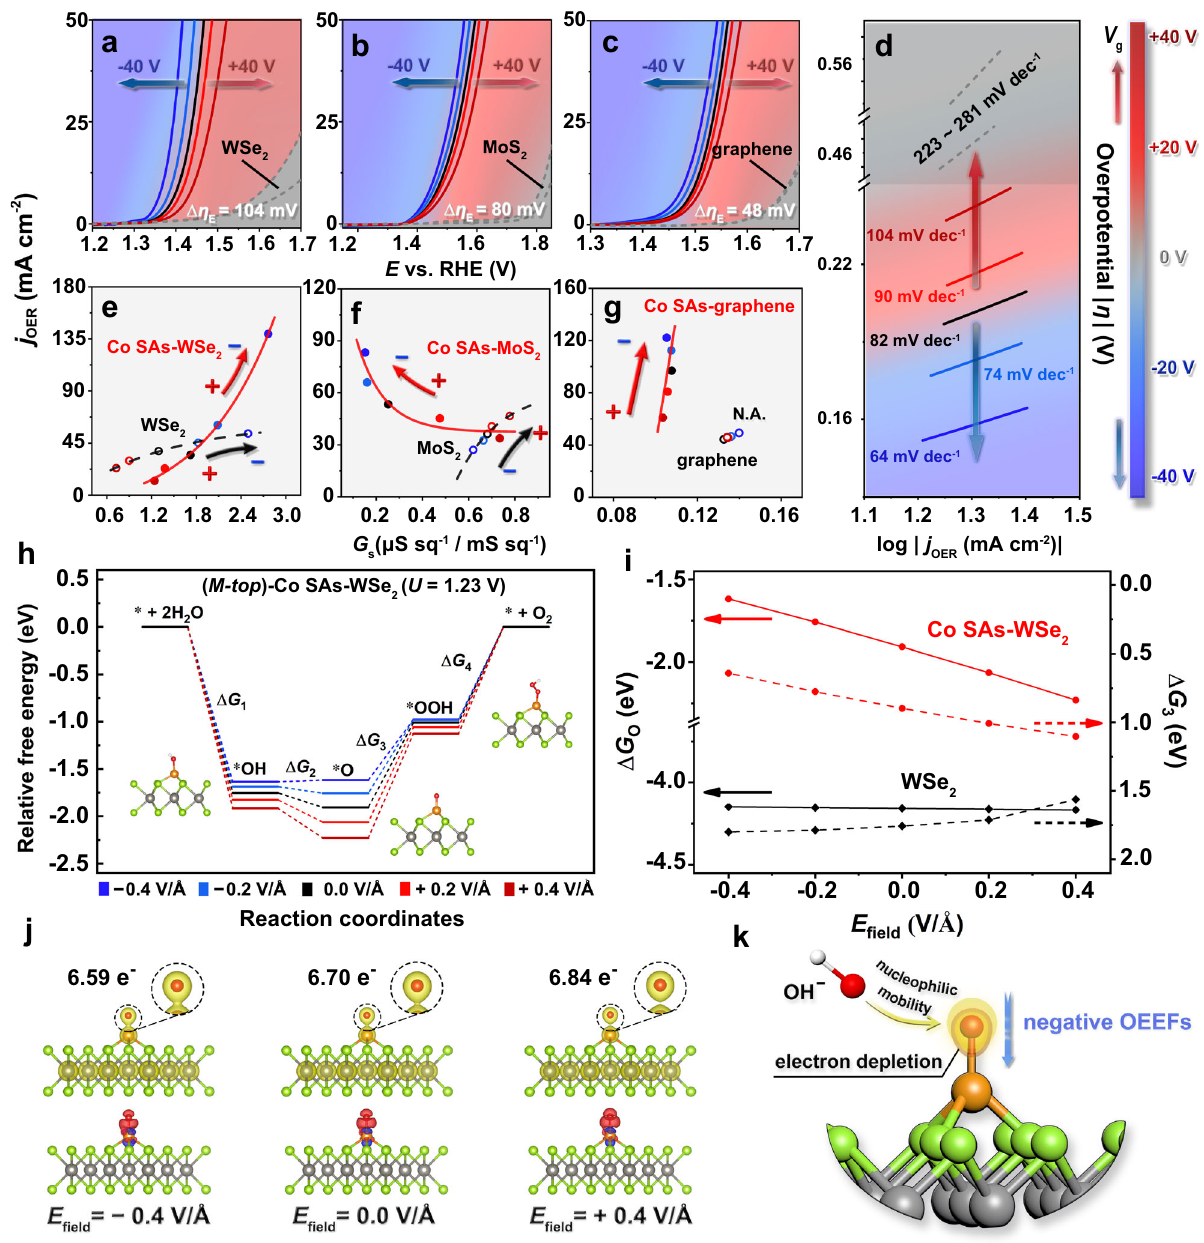
Fig. 4 OEEF-induced “ onsite electrostatic polarization ” in the Co SAs-WSe 2 catalyzed OER. a – c OER polarization curves of Co SAs-WSe 2 ( a ), Co SAs- MoS 2 ( b ), and Co SAs-graphene ( c ) in response to OEEFs. d Tafel curves of Co SAs-WSe 2 in response to OEEFs. The regions between two gray dashed lines in a – d represent the tunable OER activity of pristine 2D substrates under OEEF regulation. The color bar in a – d shows the direction and scope of V g . e – g Correlations between electrochemical current density ( j OER ) and in situ sheet conductance ( G s ) of Co SAs-WSe 2 ( e ), Co SAs-MoS 2 ( f ), Co SAs- graphene ( g ), and pristine 2D substrates under OEEF regulation. The arrows in e – g indicate the OEEF-modulation directions of performance optimization. Note that in e – g the unit of abscissa is μ S sq − 1 for Co SAs-WSe 2 and Co SAs-MoS 2 , while mS sq − 1 for Co SAs-graphene, and the values of j OER in e – g were obtained at the potentials (vs. RHE) of: 1.45 V for Co SAs-WSe 2 , 1.8 V for WSe 2 , 1.6 V for Co SAs-MoS 2 , 1.9 V for MoS 2 , 1.6 V for Co SAs-graphene, 1.8 V for graphene. h Adsorption free energies diagram of ( M-top )-Co SAs-WSe 2 for OER under OEEF regulation, where *OH, *O, and *OOH are successively absorbed on Co atom. i Comparisons of Δ G O (solid lines) and Δ G 3 (dashed lines) in 2H-WSe 2 (black) and ( M-top )-Co SAs-WSe 2 (red), with E fi eld from − 0.4 V/Å to + 0.4 V/Å. j Charge analysis of ( M-top )-Co SAs-WSe 2 under OEEF regulation, where *O is adsorbed on Co atom. Top: charge densities with interface values of 0.15 e − /Bohr 3 . The zoomed-in area shows the charge distribution at the adsorbed *O site. Bottom: deformation charge densities with interface values of 0.01 e − /Bohr 3 . Red and blue areas denote electron accumulation and depletion, respectively. E fi eld from left to right is − 0.4 V/Å, 0, and − in electrolyte tends to move towards + 0.4 V/Å. k Schematic diagram of the “ onsite electrostatic polarization ” mechanism on Co SAs-WSe 2 for OER. OH the adsorbed *O site, where electron depletion was triggered by negative